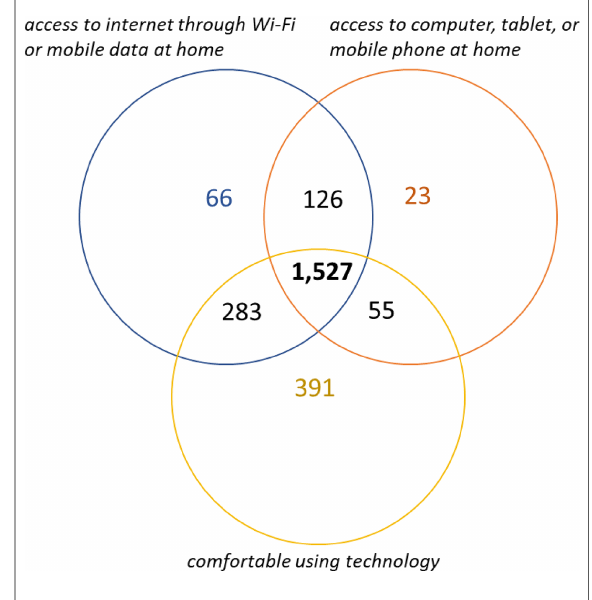
FIGURE 1 Digital readiness disposition among the All of Us participants at FQHCs. [Total number of participants=2,791. Digital readiness was de fi ned by access to home-based or other internet-accessing devices (computers, tablets, mobile phones, and other devices) and participants ’ comfort level using such